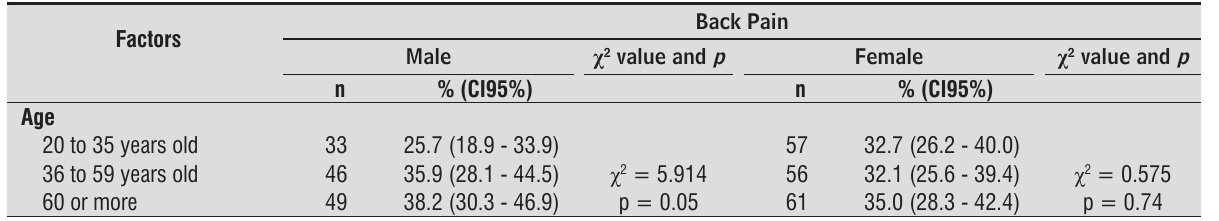
Table 2 - Bivariate analysis between sociodemographic characteristics – smoking and physical activity level and pain in spine – from subjects over 20 years old, living in the city of Bauru (São Paulo, Brazil), by gender